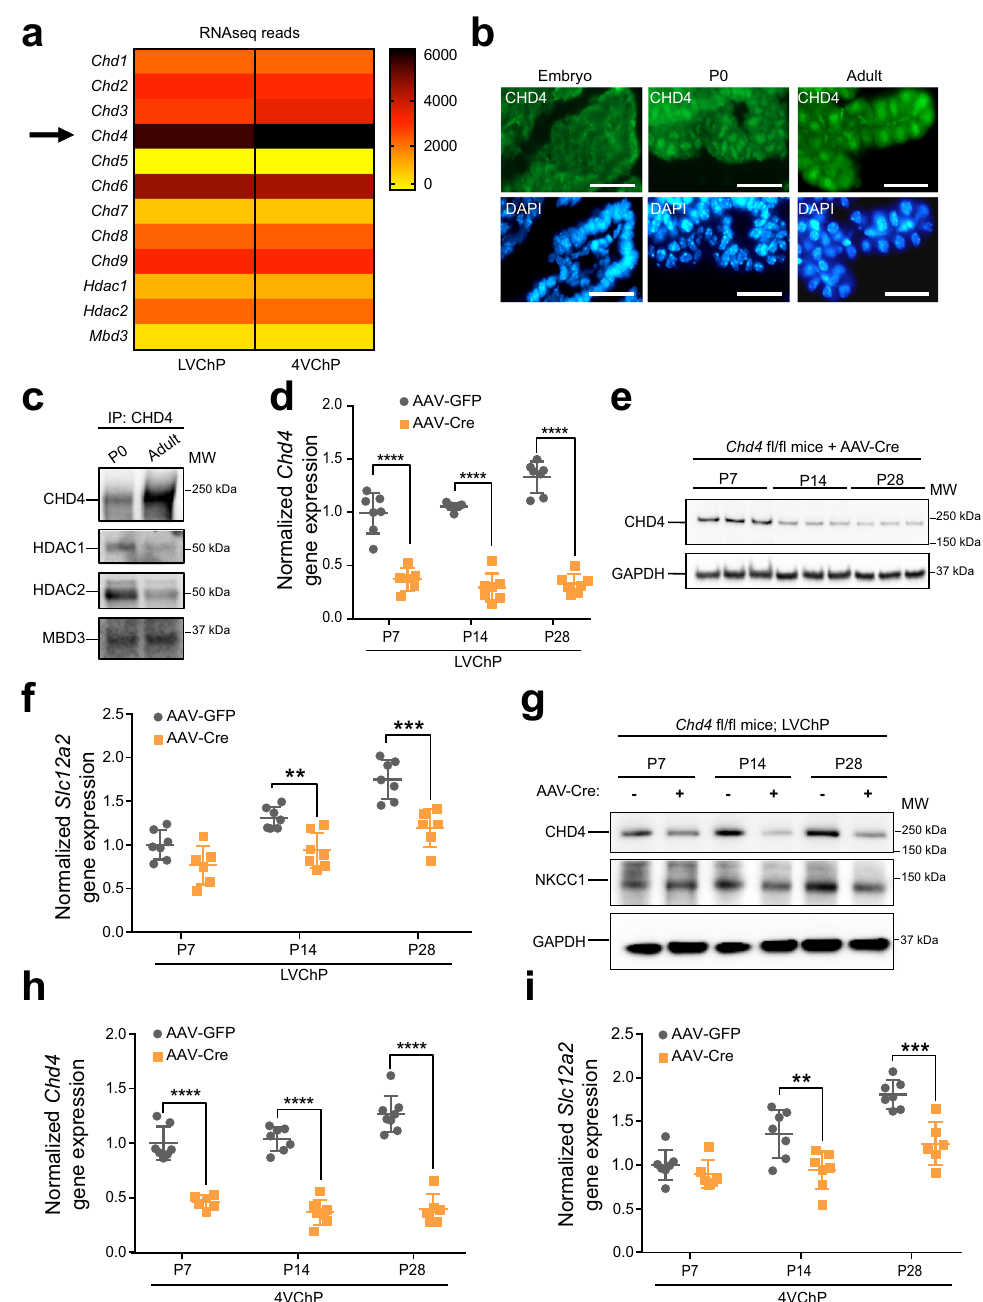
Fig. 3 NKCC1 temporal expression requires the CHD4/NuRD complex. a RNA-seq data showing expression of CHD and other NuRD units by the ChP. Yellow: low expression; Dark brown: high expression. b Immuno fl uorescence images of CHD4 in the ChP epithelia at E16.5, P0, and adult; Scale bar = 30 µ m. A total of four animals at each age were imaged in two independent experiments. c Immunoblots of Co-IP by CHD4 antibody. Representative of two independent experiments, each contain more than 10 animals for each age. d RT-qPCR of CHD4 transcripts in ChP with AAV2/5-Cre transduction. Gray: AAV-GFP; orange: AAV-Cre (same color scheme is used for the rest of the fi gure). **** p < 0.0001, N = 7, Welch ’ s two-tailed unpaired t -test. e Immunoblot of CHD4 in AAV-Cre mice ChP lysate, representative of three independent experiment, each contain two or three independent animals. f RT-qPCR of NKCC1 expression in AAV-Cre vs. AAV-GFP mice ChP. All values were normalized to P7 AAV-GFP control mice. ** p = 0.0015, *** p = 0.0009, N = 7, Welch ’ s two-tailed unpaired t -test. g Immunoblot of NKCC1 in LVChP lysates from AAV-Cre vs. AAV-GFP mice, representative of three independent experiments, each containing two or three independent animals (same samples as those collected for Fig. 2e). h , i CHD4 and NKCC1 RT-qPCR in 4VChP. ** p = 0.0083, *** p = 0.0005, **** p < 0.0001, N = 7, Welch ’ s two-tailed unpaired t -test. All quantitative data are presented as mean ± SD. When immunoblots were quanti fi ed, all samples for quantitative comparison were on the same blot. Source data are provided as a Source Data fi